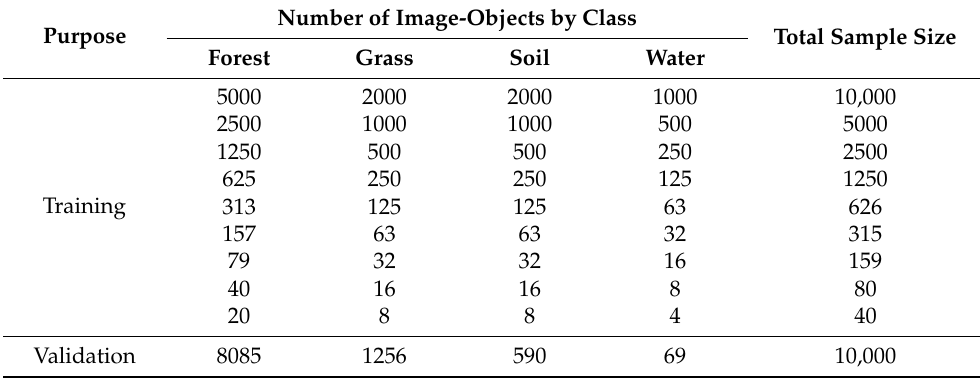
Table 3. Training and validation data sample sizes and